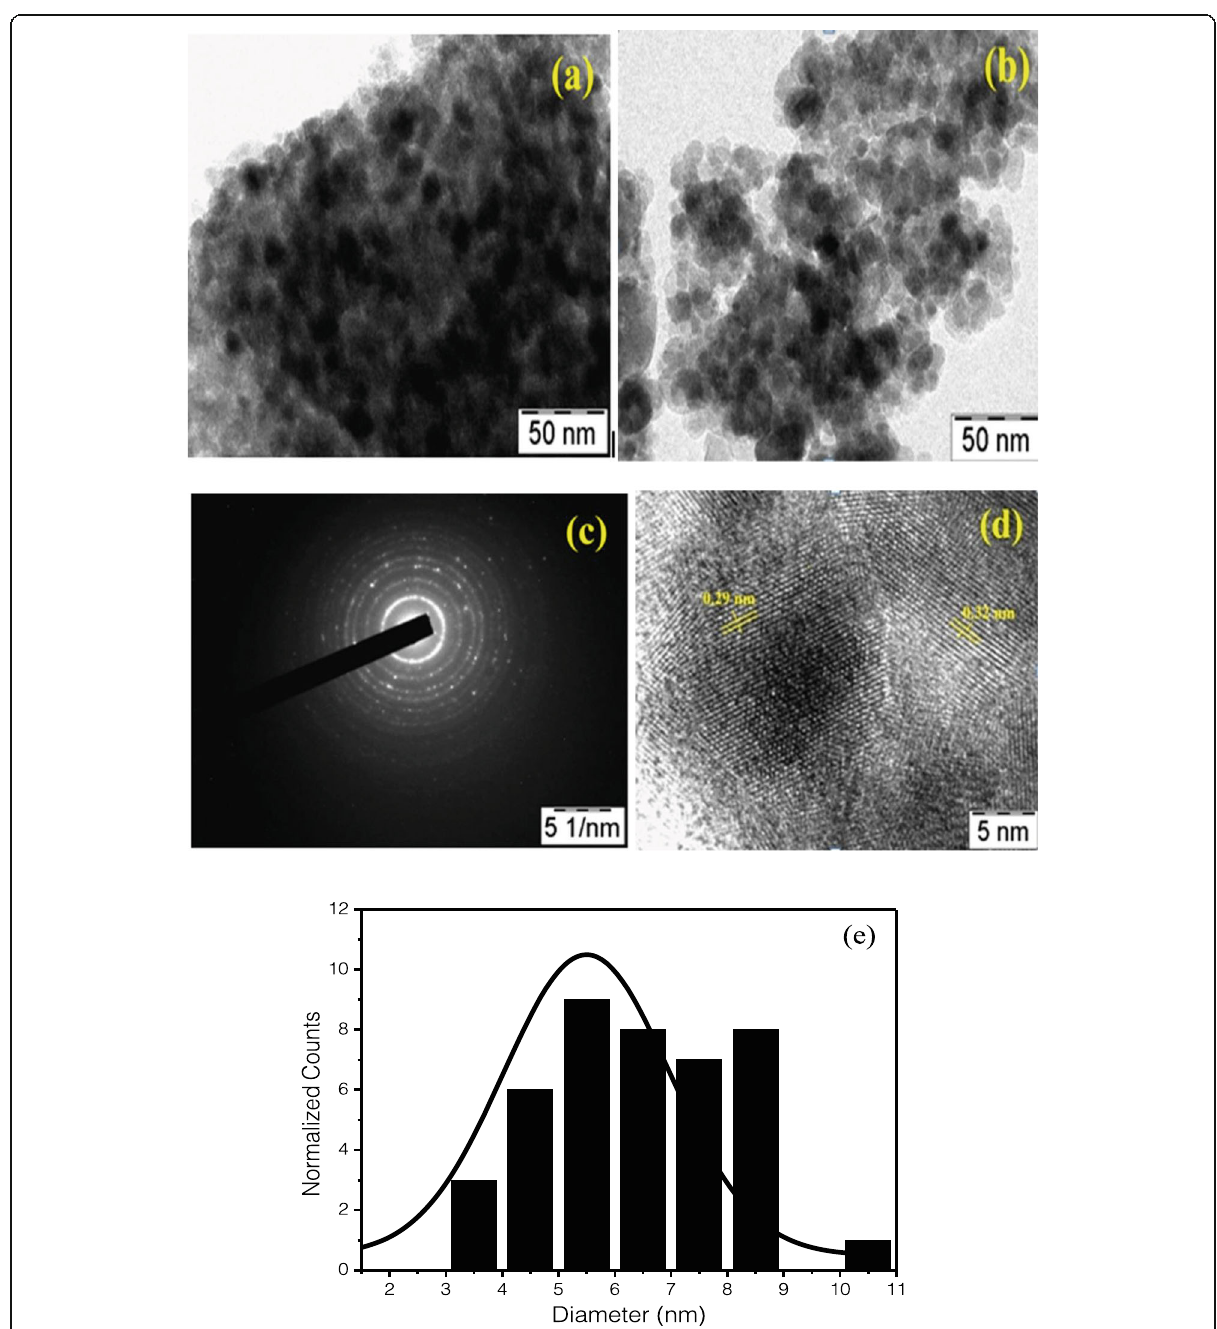
Fig. 6 TEM images of ( a ) undoped TiO 2 , ( b ) 0.5 wt% of Zn & 0.5 wt% of B co-doped TiO 2 , ( c ) SAED pattern ( d ) HRTEM image and ( e ) particle size distribution of 0.5 wt% of Zn & 0.5 wt% of B co-doped TiO